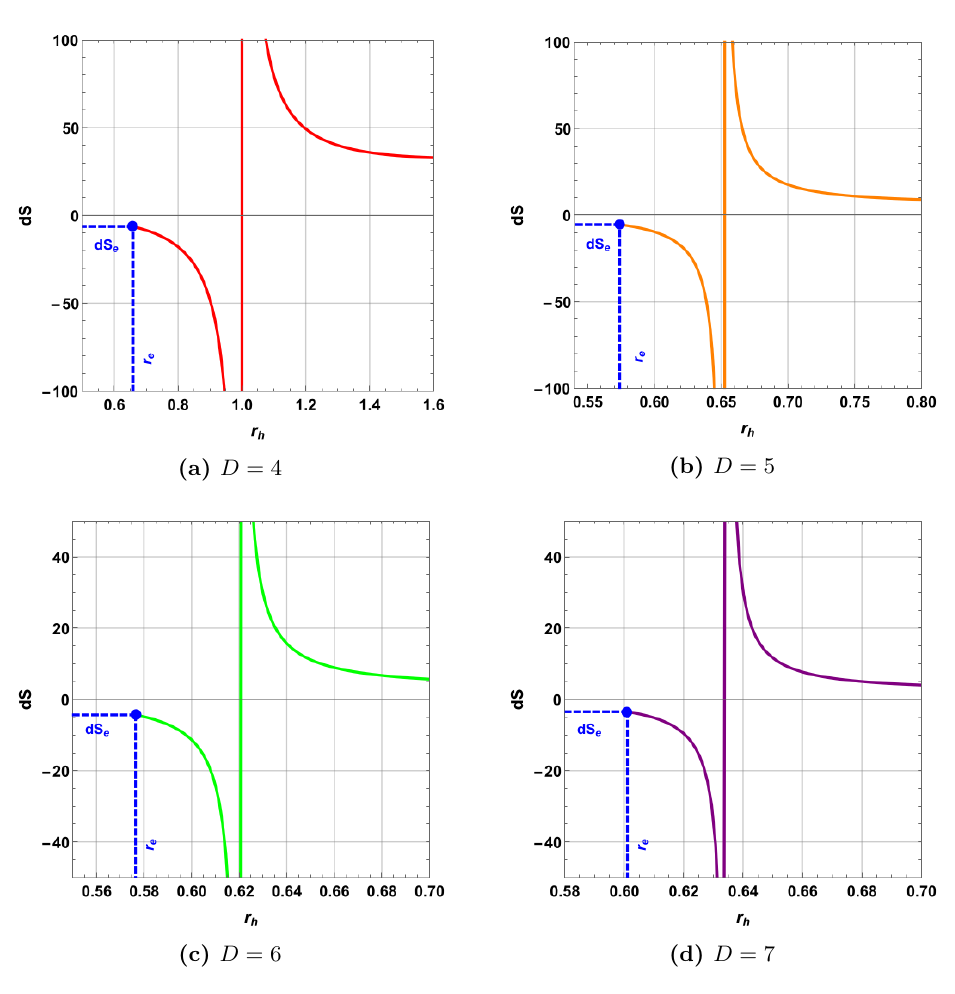
Figure 1. Entropy variation dS as a function of event horizon radius r h for different dimensions with | p r | = 1 , Q = 1 , l = 1 and dQ = 0 . 1 h